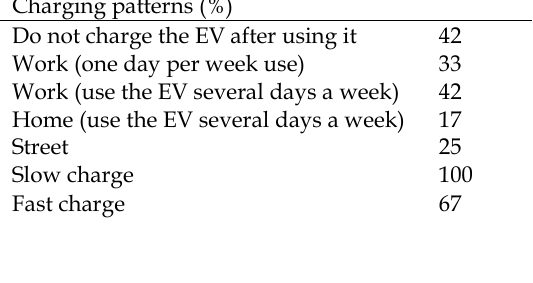
Table 11 Fleet users charging patterns (percentage of